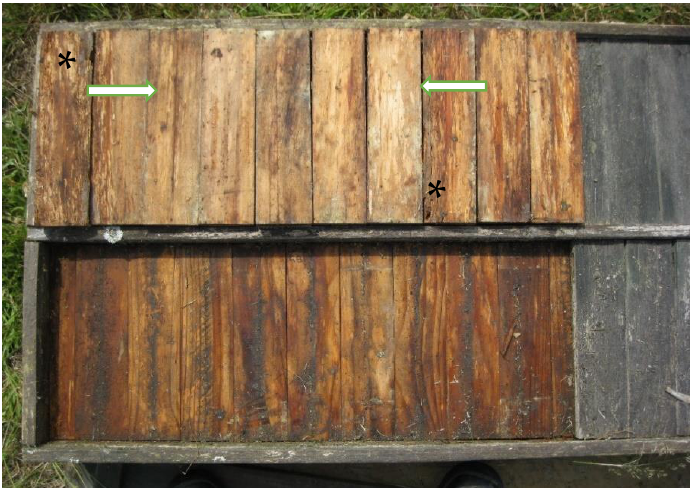
Figure 6. Double layer test after 10 years exposure. The upturned samples 3rd–7th from left, upper row) are copper-chrome arsenate (CCA)-treated (between two arrows), all others are untreated controls. The upper surface of the second layer opposite in the lower row is the same treatment. Note that there is very little decay in the CCA treated samples but there is severe decay in all of the untreated samples (examples of visible decay are indicated by asterisk * symbol).